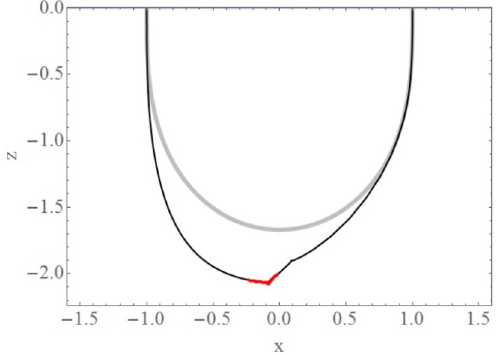
Figure 15 . Cusp and anticusp on the string. The shG and chG regions are indicated by red and black, respectively. The anticusp lies in the shG region (at x ≈ − 0 . 1 ) and the cusp is located in the chG region (at x ≈ 0 . 1 ). The initial static configuration before the quench is shown in gray. the number of string segments used in the simulation ( N = 300 and 100, kink